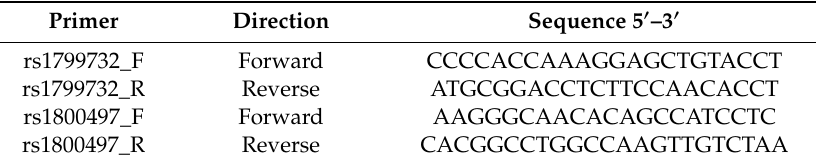
Table 1. Primers for amplifying DRD2 gene polymorphisms by